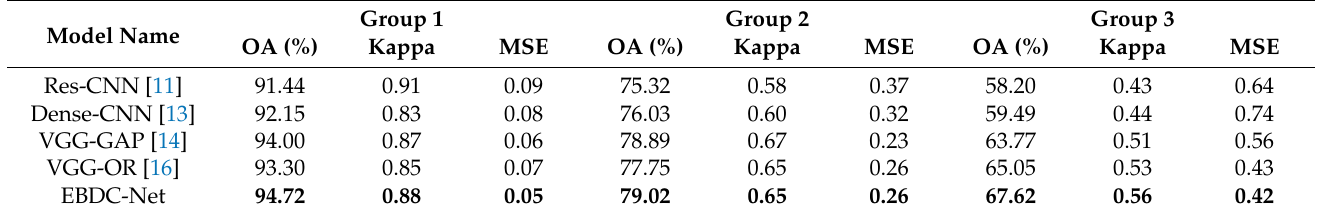
Table 11. Comparison of different methods for the task of classifying building damage in the Yushu